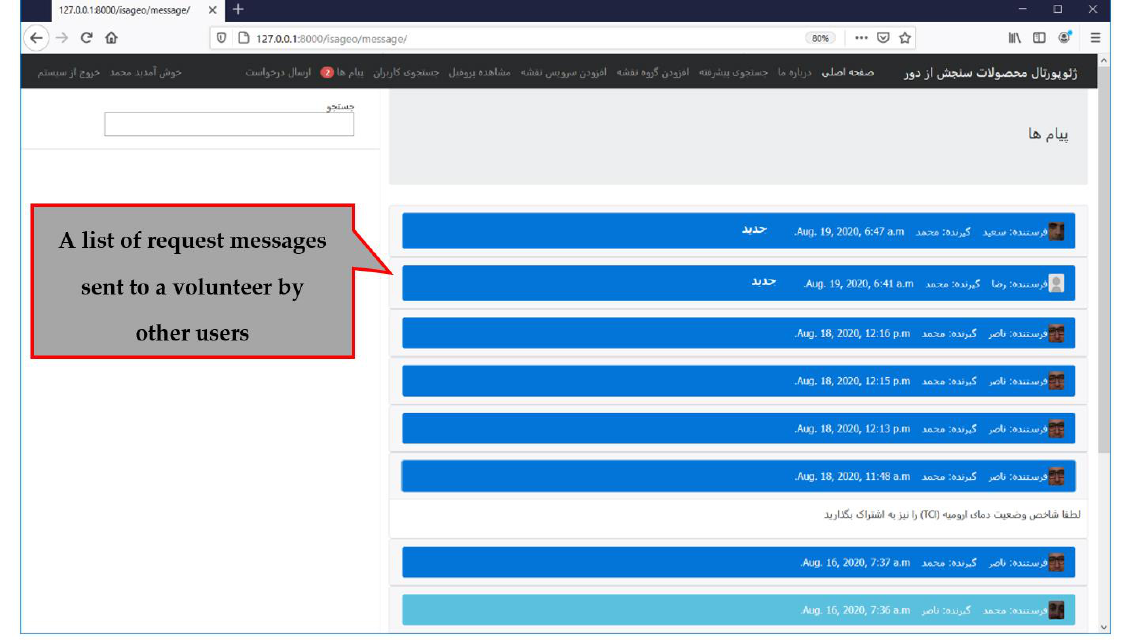
Figure 12. Sending or receiving request messages to publish an EO product.